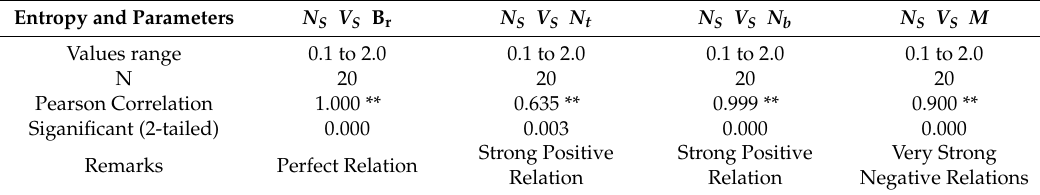
Table 3. Correlation table between entropy generation and parameters.